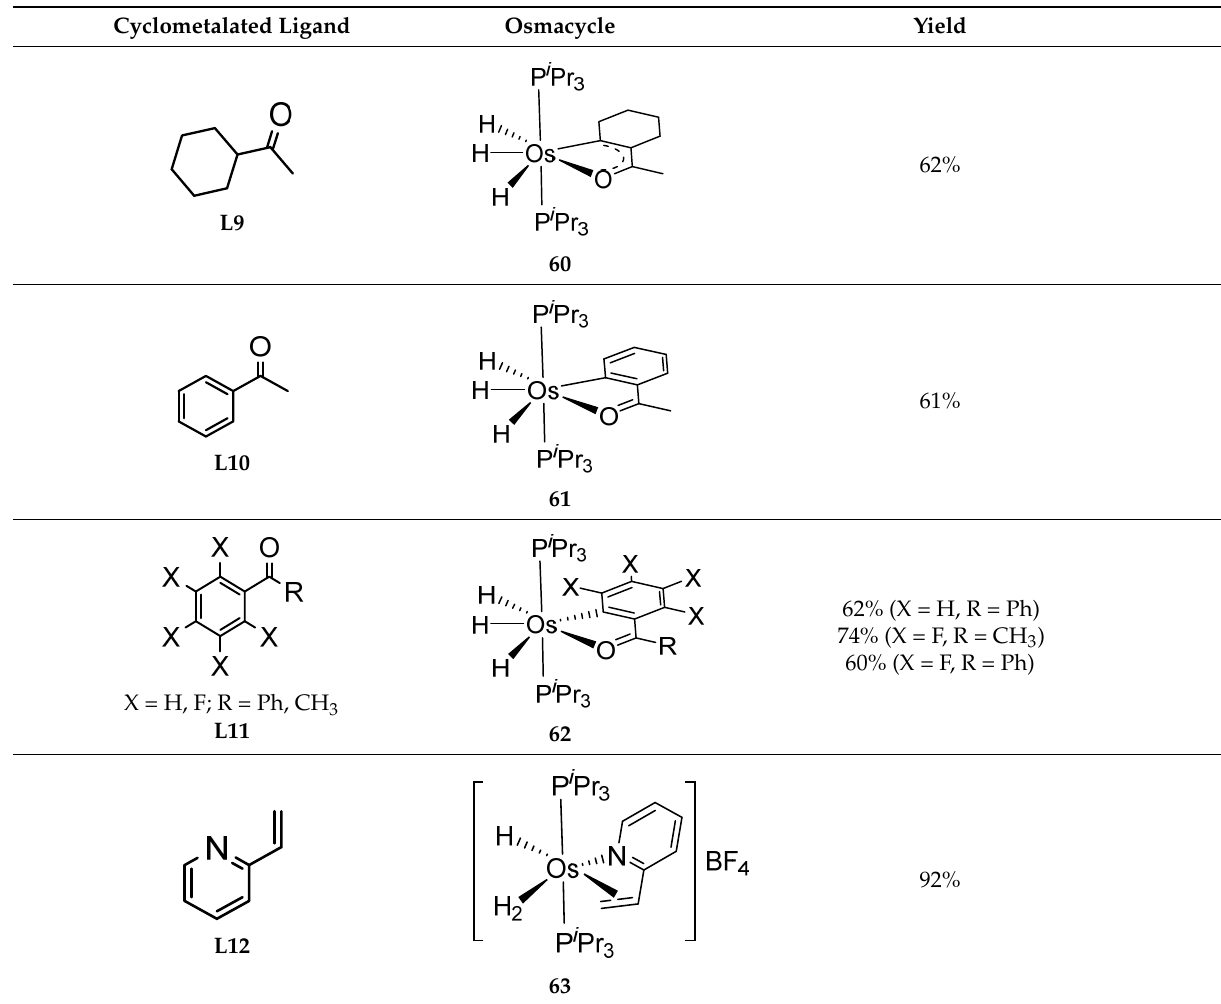
Table 2. Osmacycles obtained from [OsH 6 (P i Pr 3 ) 2 ].